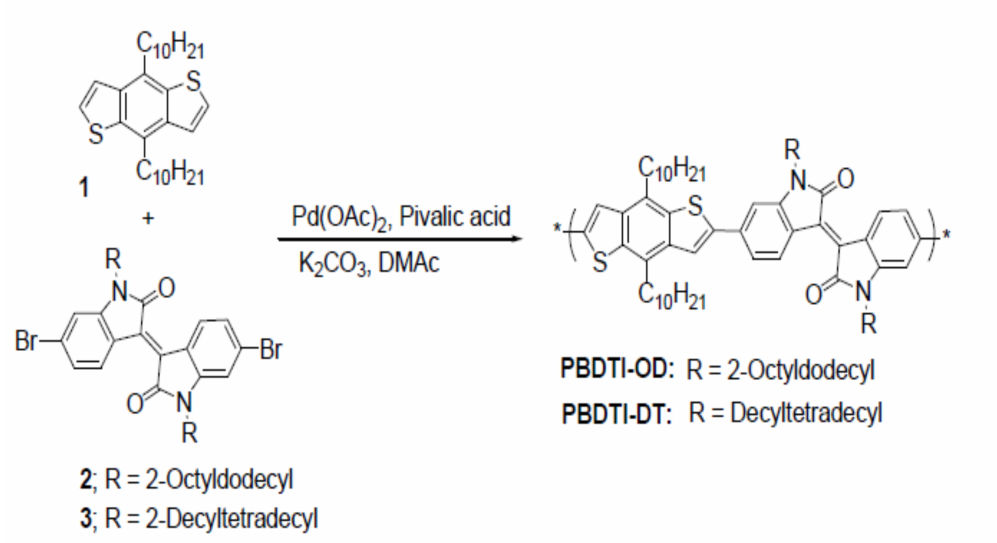
Scheme 1. Syntheses scheme of PBDTI-OD and PBDTI-DT